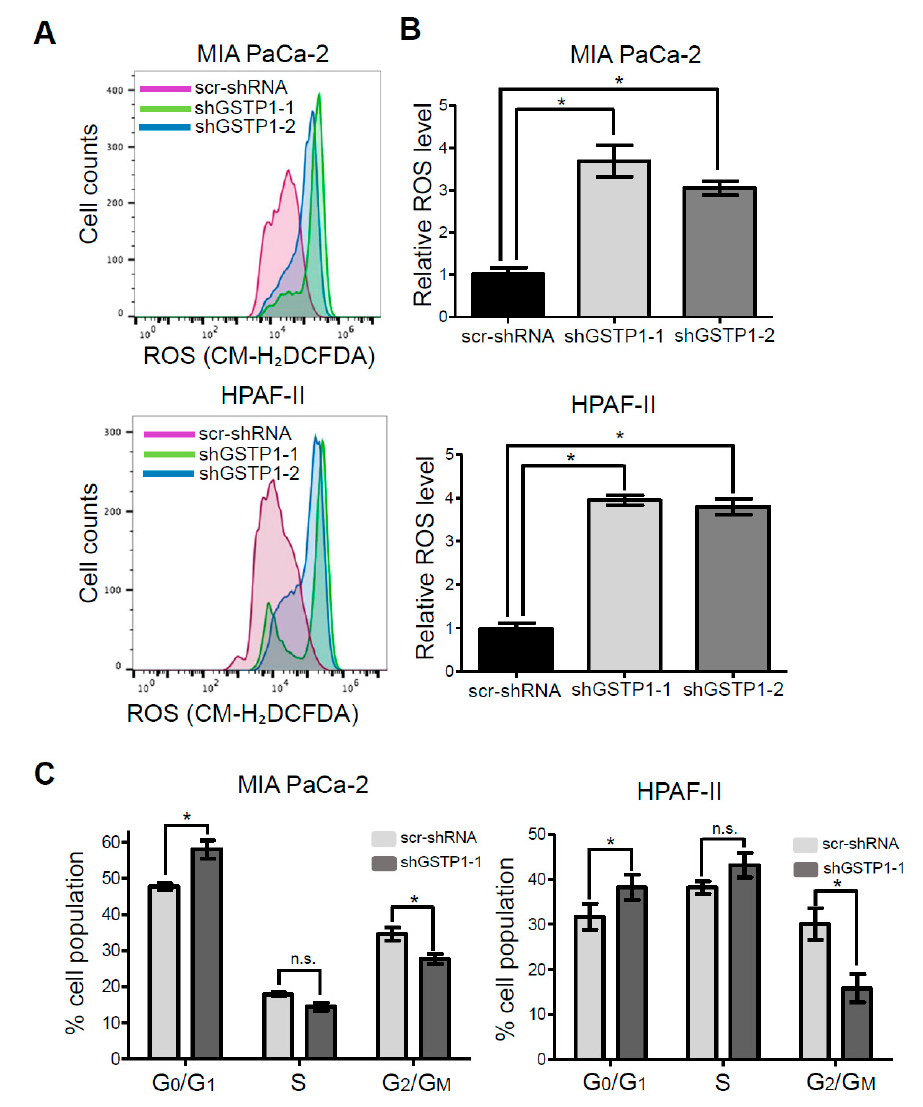
Figure 3. Effect of GSTP1 knockdown on the cell cycle profile and reactive oxygen levels (ROS)